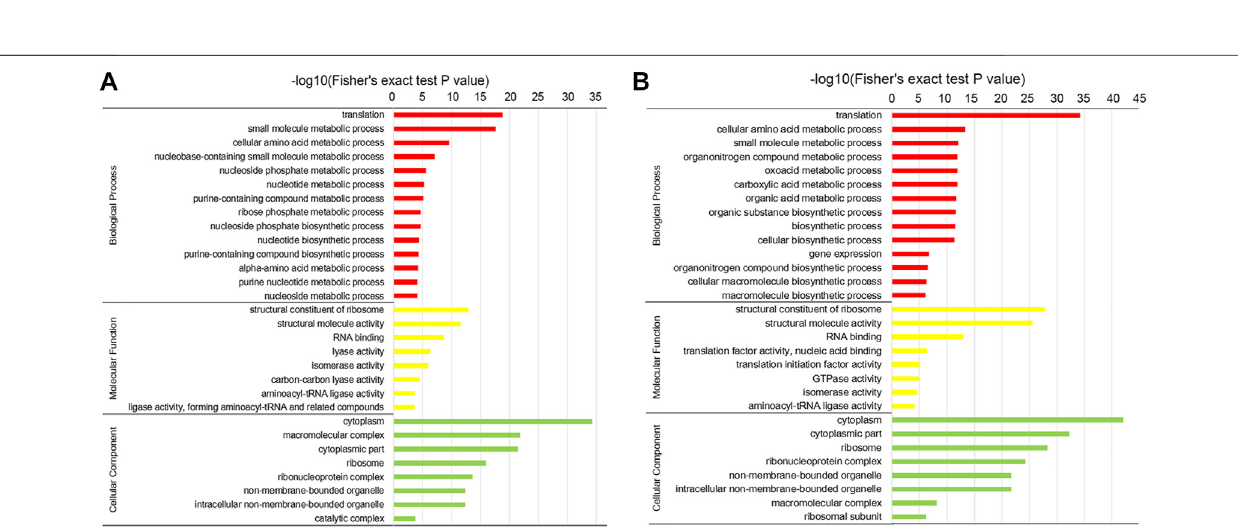
Frontiers in Genetics |